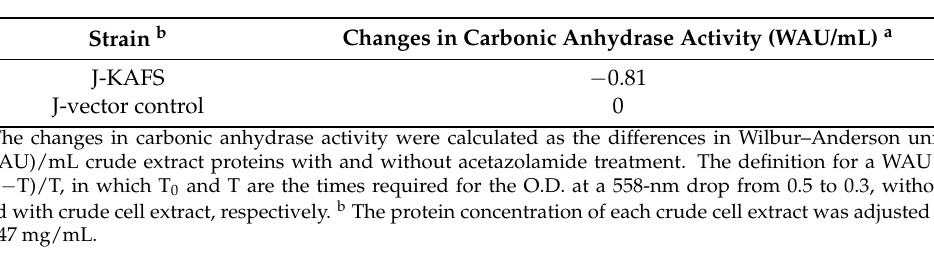
Table 6. Changes in carbonic anhydrase activities in crude extract proteins of transgenic strains after treatment with